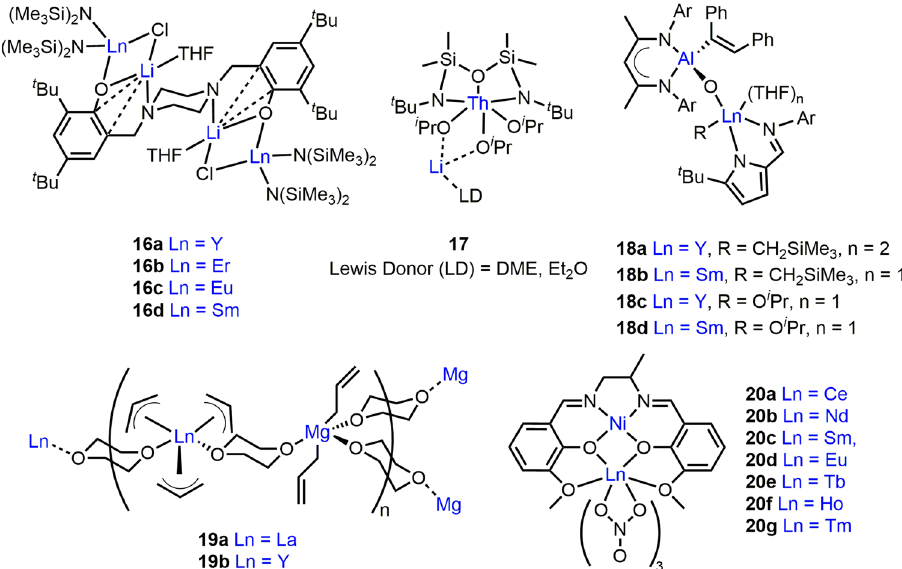
Fig. 4 Heterometallic ROP catalysts featuring f-block elements. Structural representations of cyclic ester ROP catalysts combining lanthanides or actinides with alkali metals, divalent metals, trivalent metals or transition